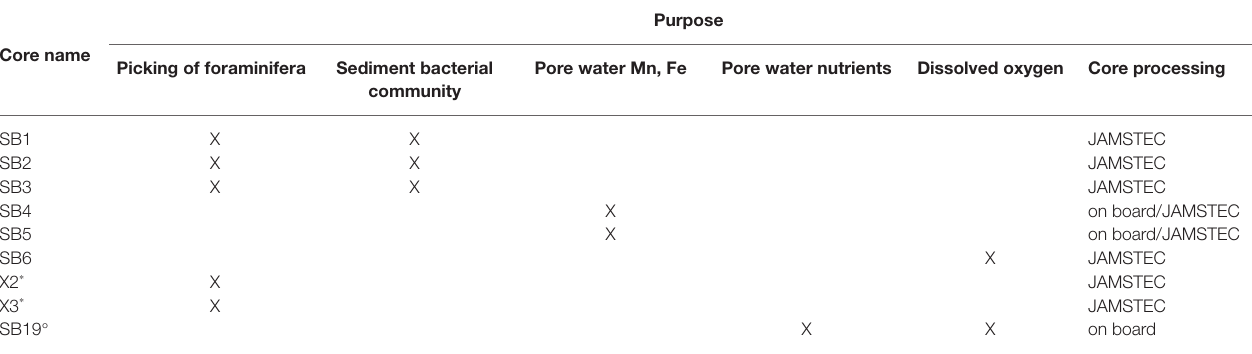
TABLE 1 | Sediment cores used in this study and their